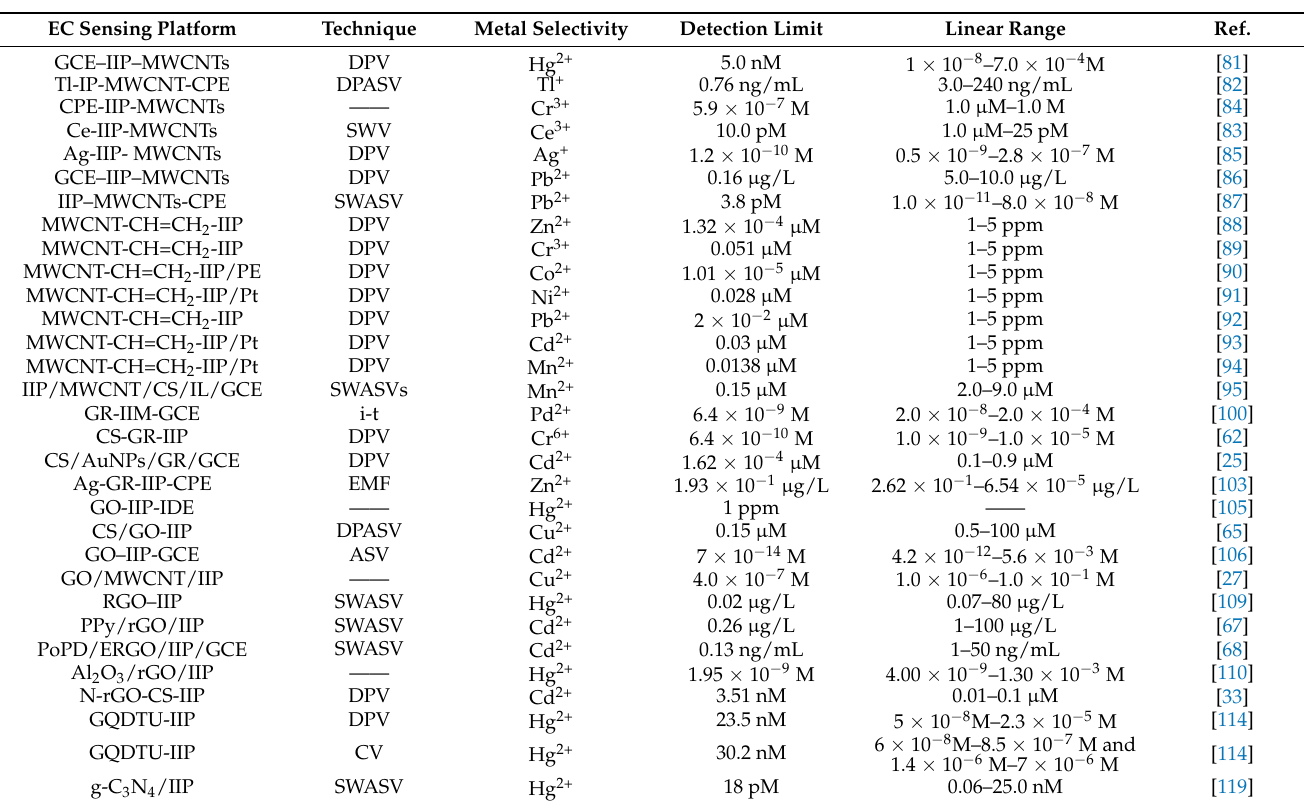
Table 3. Carbon nanomaterials-based HMIIECSs for the detection of HMIs. EC Sensing